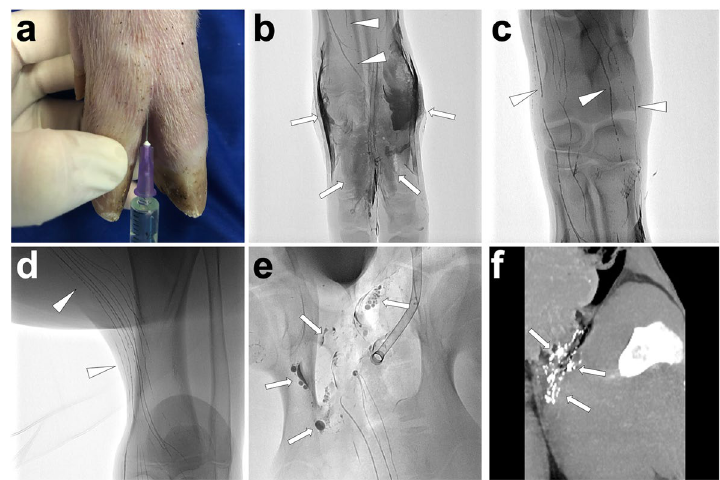
Fig. 6 Illustration of lipiodol-based interstitial lymphangiography in a pig model. First, inject 2 ml lipiodol at each interdigital space of the left foot, similar to the interstitial dye test ( A ). After 15 min, the interstitial ( white arrows ) and surrounding lymphatic vessels ( white arrowheads ) were opacified under fluoroscopy ( B ). Over time, the lymphatic vessels ( white arrowheads ) at the ankle ( C ) and lower leg ( D ) were visually opacified under fluoroscopy. When the lipiodol reached the left groin region, evident extravasation of lipiodol ( white arrows ) was observed with the disruption of lymphatic vessels, indicating a typical PLL diagnosis ( E ). The coronal MIP image of the sequential post-lymphangiography CT demonstrated the subcutaneously sporadic distribution of lipiodol ( white arrows ) at the left groin ( F ). Images were from Pig No. 10 . Abbreviations: PLL, postoperative lymphatic leakage; MIP, maximum intensity